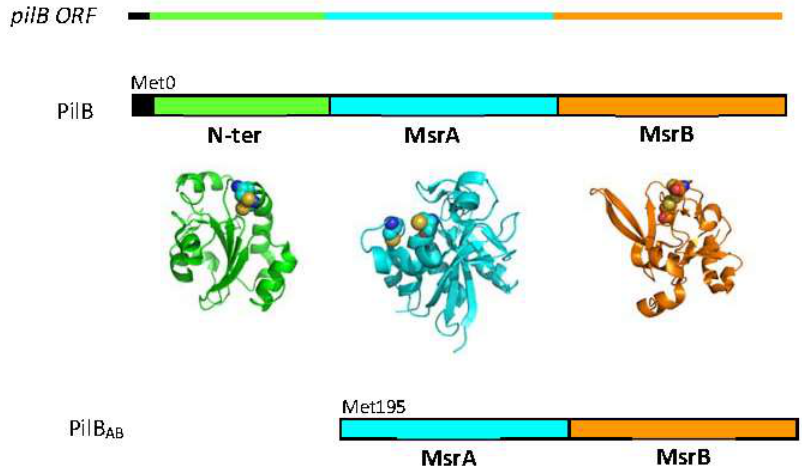
Figure 2. The N. meningitidis pilB ORF contains a signal peptide (black) and the coding sequences for the three functional domains (green for N -ter, cyan for MSRA and orange for MSRB). The three domain protein (PilB) is located in the periplasm, whereas the cytoplasmic form contains only the two MSR domains (PILB AB ). The structures of the isolated N -ter (pdb 2fy6), MSRA (pdb 3bqe) and MSRB (pdb 3hcg) domains were generated using the PyMol program (DeLano Scientific LLC, San Carlos, CA, USA).